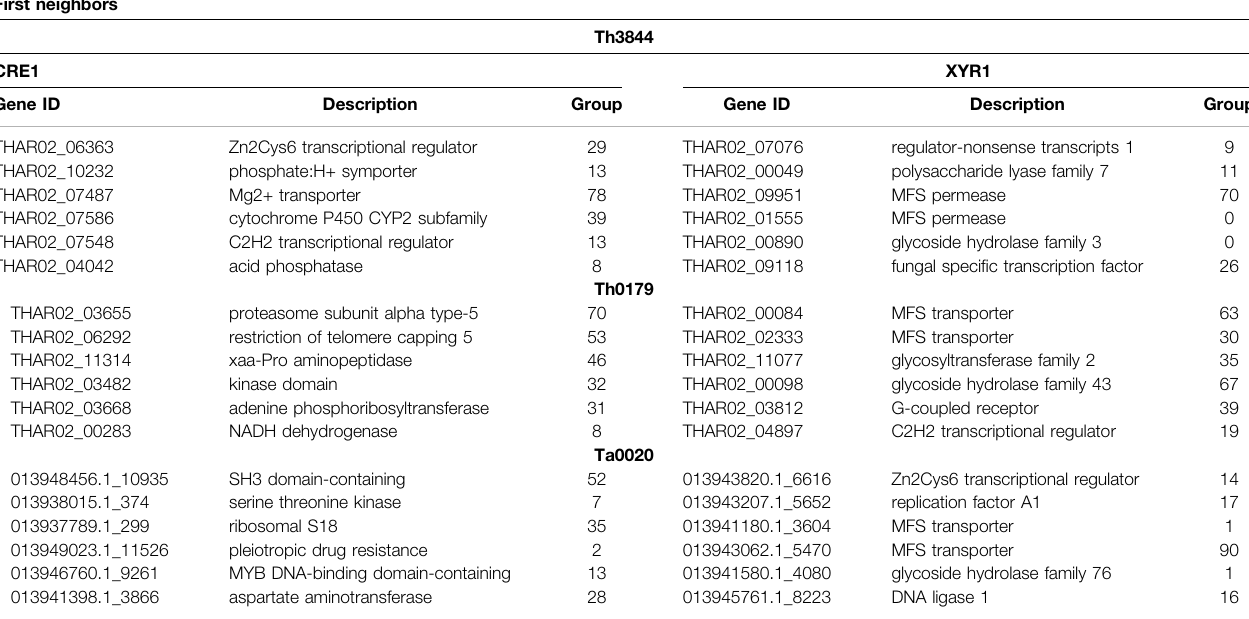
TABLE 1 | First neighbors of the transcripts xyr1 and cre1 identi fi ed in Th3844, Th0179, and Ta0020. First